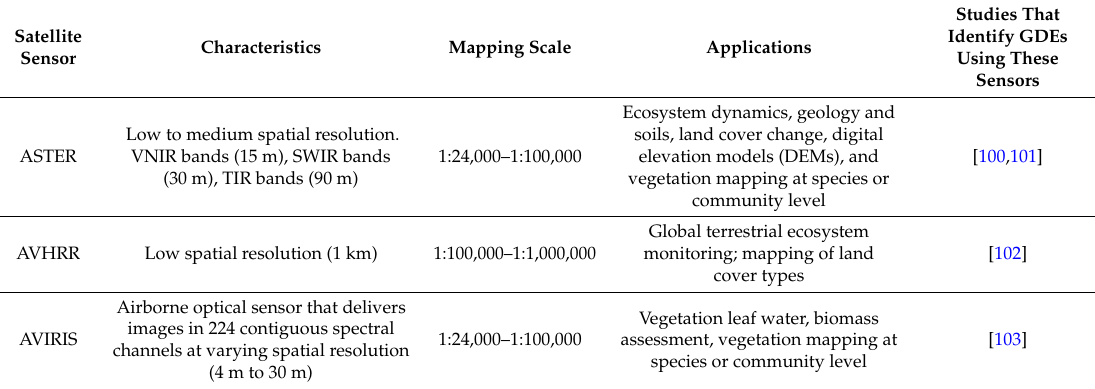
Table 1. Main features of the most suitable sensors for delineation of GDEs and studies that have focused on the use of these